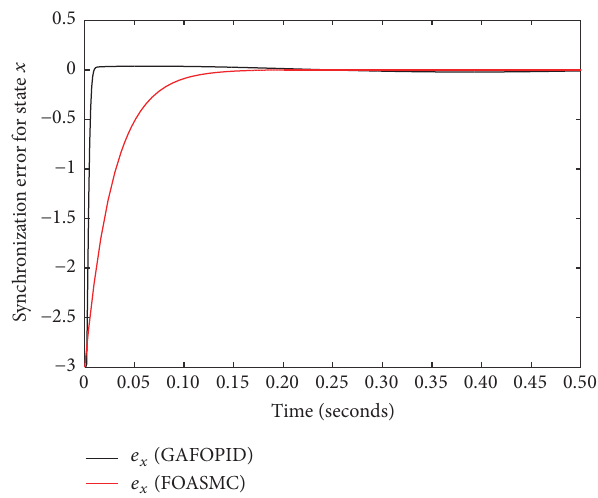
Figure 17: Comparison of synchronization errors (ASMC and GAFOPID).